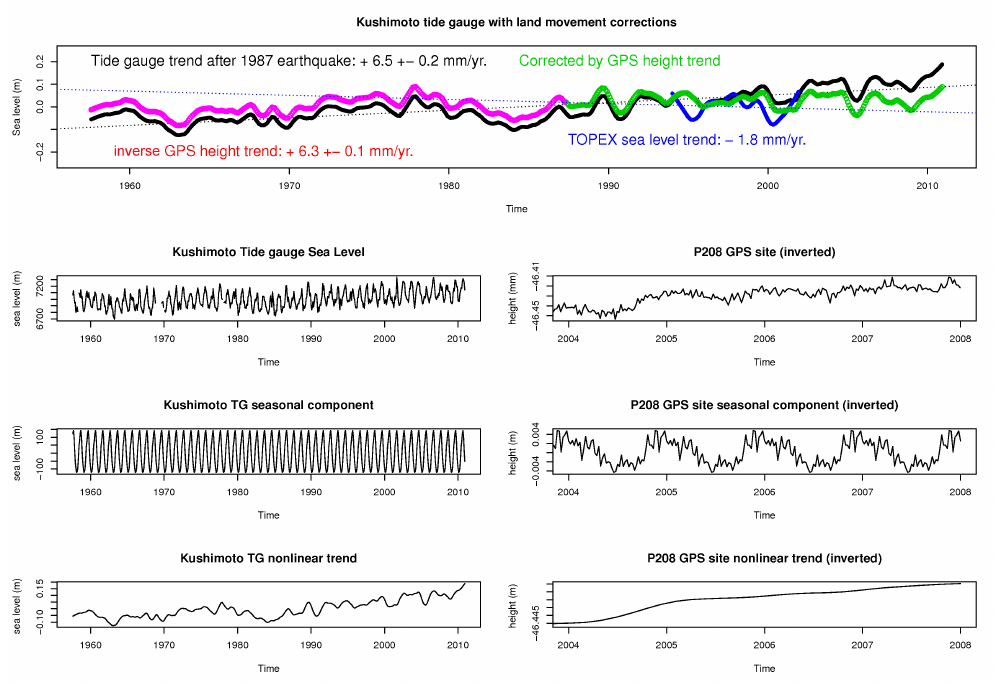
Fig. 13. The apparent sea level rise (+6 . 5 ± 0 . 2mmyr − 1 ) at Kushimoto tide gauge after the 1987 Wakayama prefecture earthquake and its comparison with the height trend ( − 6 . 3 ± 0 . 1mmyr − 1 ) at the co-located GPS station